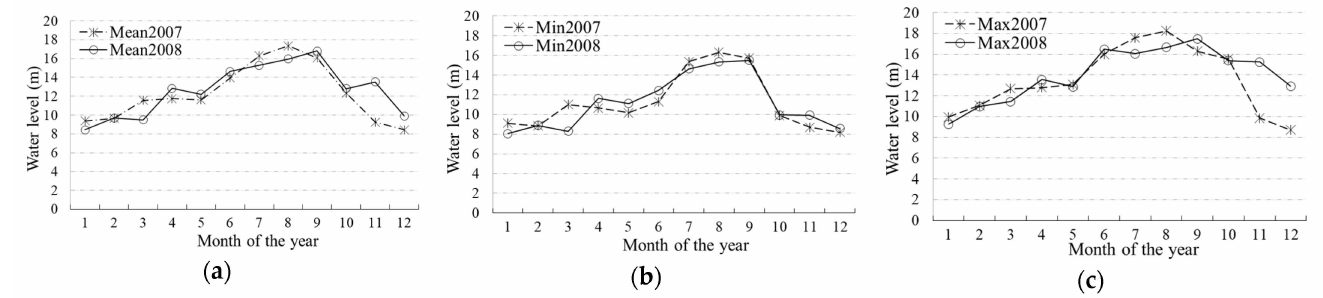
Figure 2. Monthly ( a ) mean, ( b ) minima, and ( c ) maxima of water level (m) between 2007 and